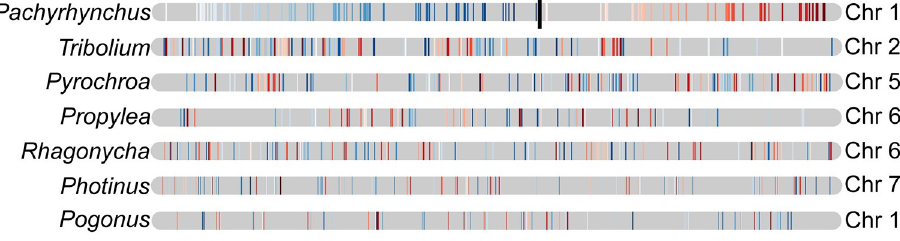
Fig 6. Pachyrhynchus sulphureomaculatus chromosome 11 and matching homologous chromosomes from taxa samples across the Coleoptera. Top row, approximate position of Pachyrhynchus chromosome 11 centromere marked with black line, position derived from Hi-C contact map (see Fig 1). Colored lines correspond to the position of BUSCO genes. Blue colors correspond to one chromosome arm and red colors the other. While the majority of BUSCO genes found in Pachyrhynchus chromosome 11 are retained in the other species there is extensive reshuffling in their positions.